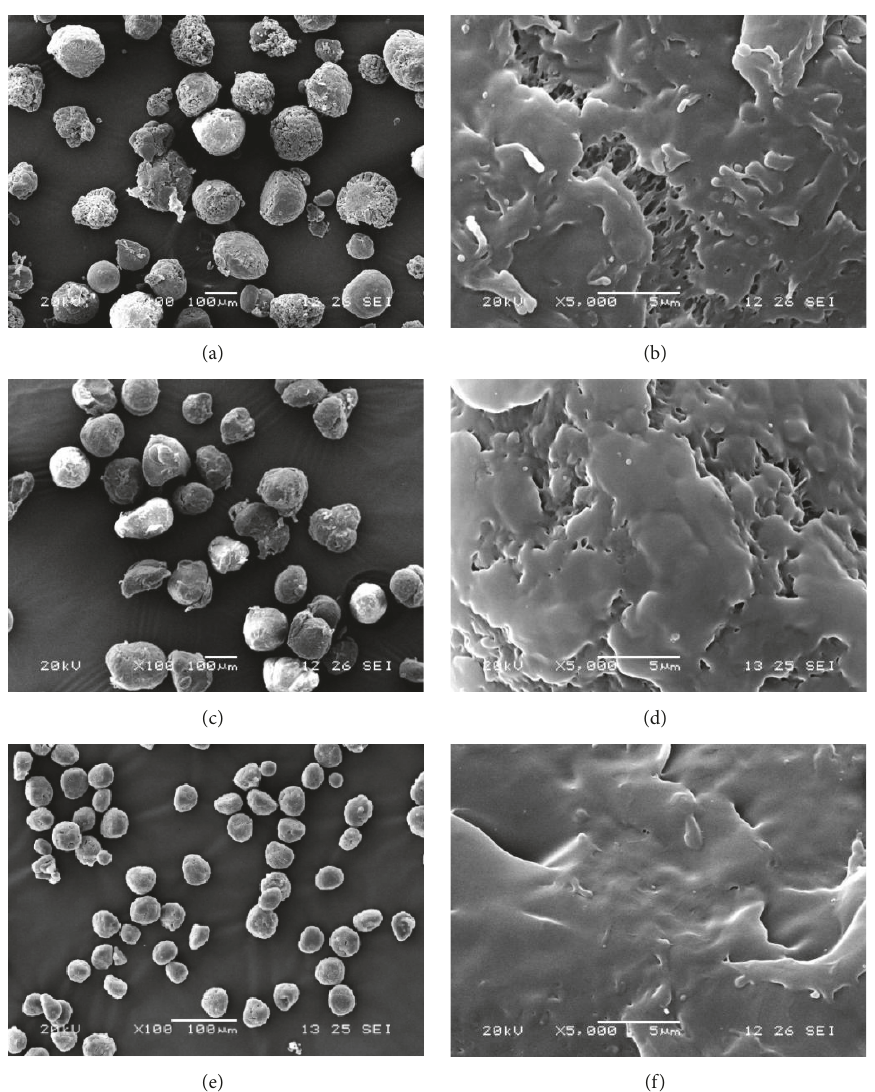
Figure 5: SEM graphs of PP powders prepared on different conditions: (a), (b) dissolution temperature 166 ∘ C; (c), (d) dissolution temperature 166 ∘ C and solid-to-solvent ratio 0.067g/ml; (e), (f) dissolution temperature 166.0 ∘ C, solid-to-solvent ratio 0.067g/ml, and pressure 0.7MPa.